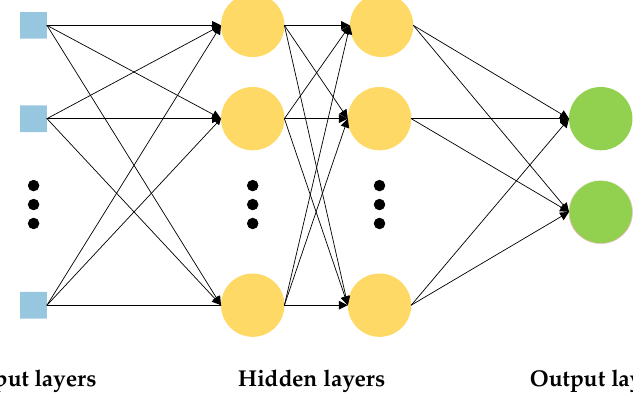
Figure 3. MLP model structure.